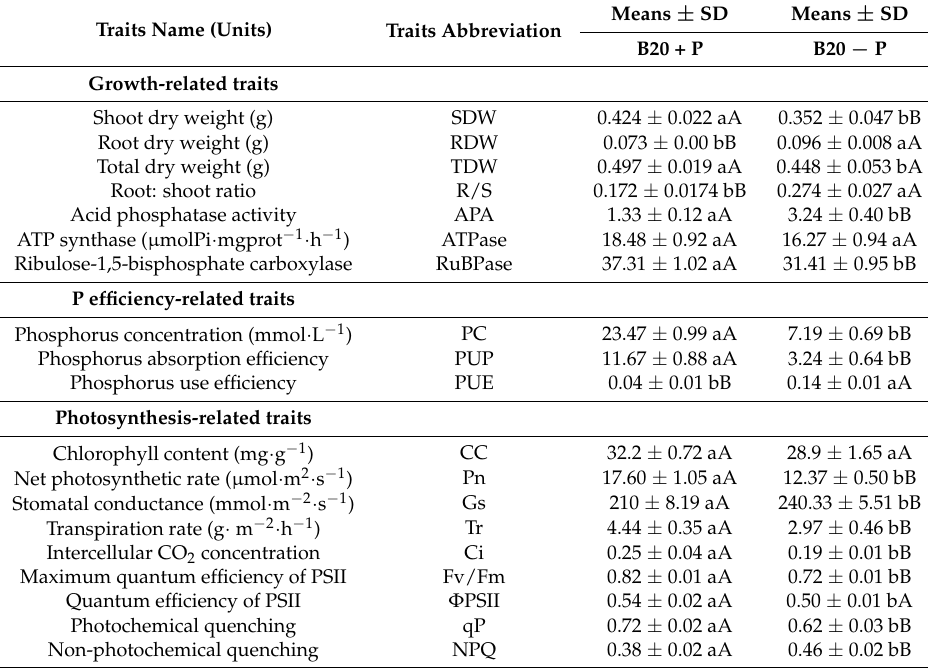
Table 1. Phenotypic variation of photosynthetic- and P efficiency-related traits in soybean.